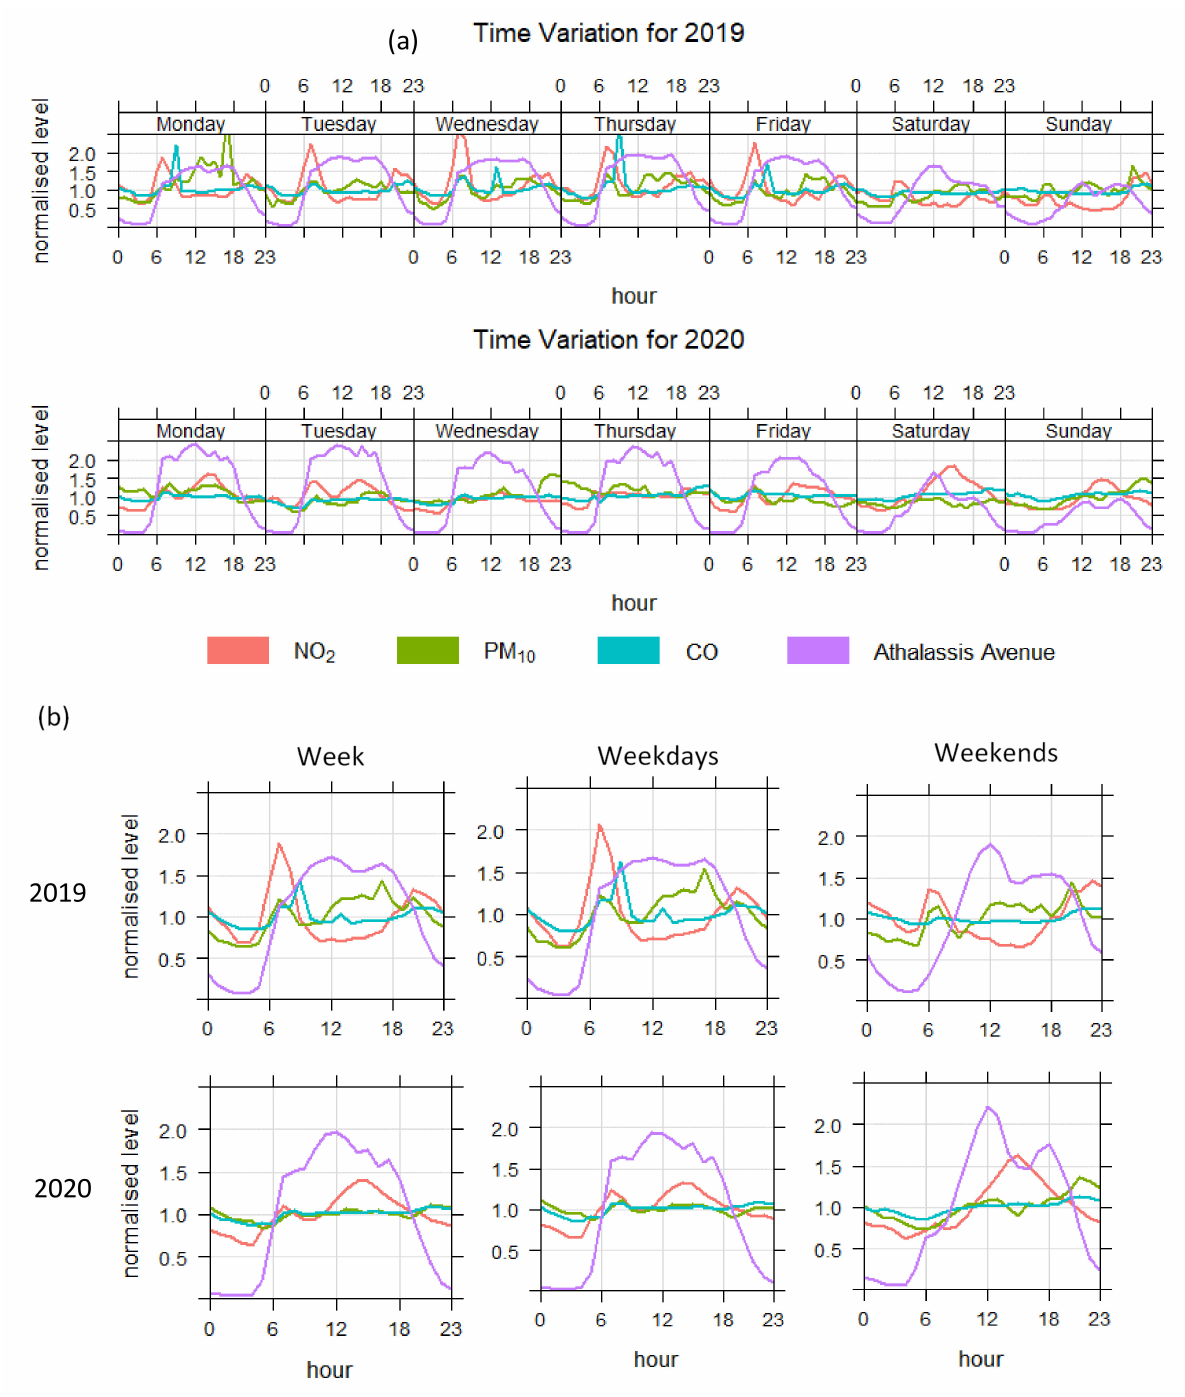
Figure 6. The change of the normalized average value ( a ) of each hour per day of the week and the change of the normalized average value ( b ) of each hour during the day, for the three study pollutants (NO 2 (red), CO (blue), PM 10 (green)) for the P2/2019 and P2/2020 and average number of cars for Athalassis avenues